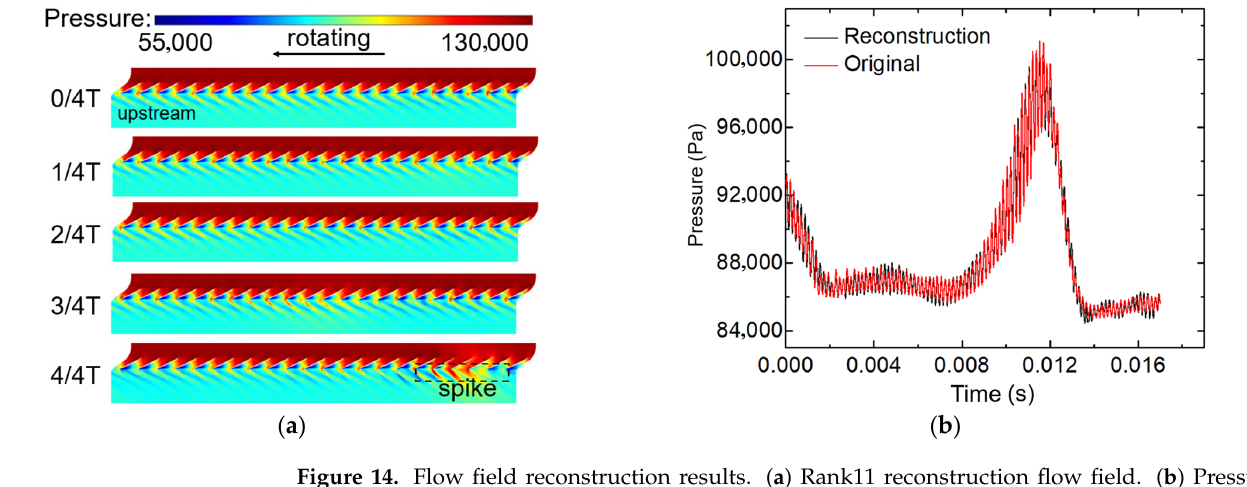
Figure 14. Flow field reconstruction results. ( a ) Rank11 reconstruction flow field. ( b ) Pressure collected by the probe in front of the tip leading edge.